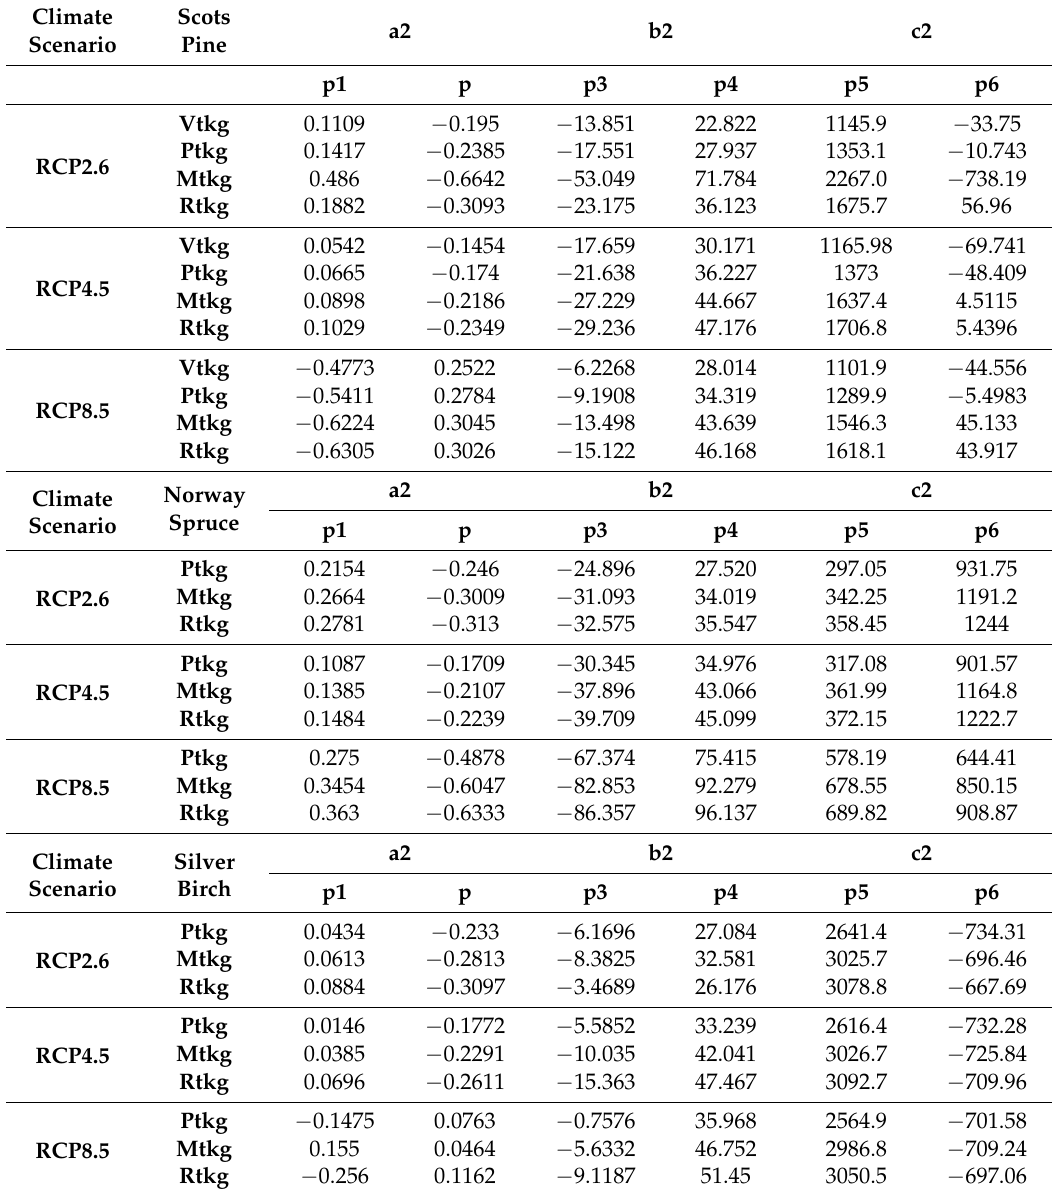
Table A3. Parameters used in Equation (4) for different climate change (cc) scenarios on Vtkg, Ptkg, Mtkg, and Rtkg drained peatland sites with fertility comparable to that of poor (dry heath, Calluna type, CT), quite poor (dryish heath, Vaccinium type, VT), medium (fresh heath, Myrtillus type, MT), and rich (grove-like heath, Oxalis-Myrtillus type, OMaT) upland sites (see Table